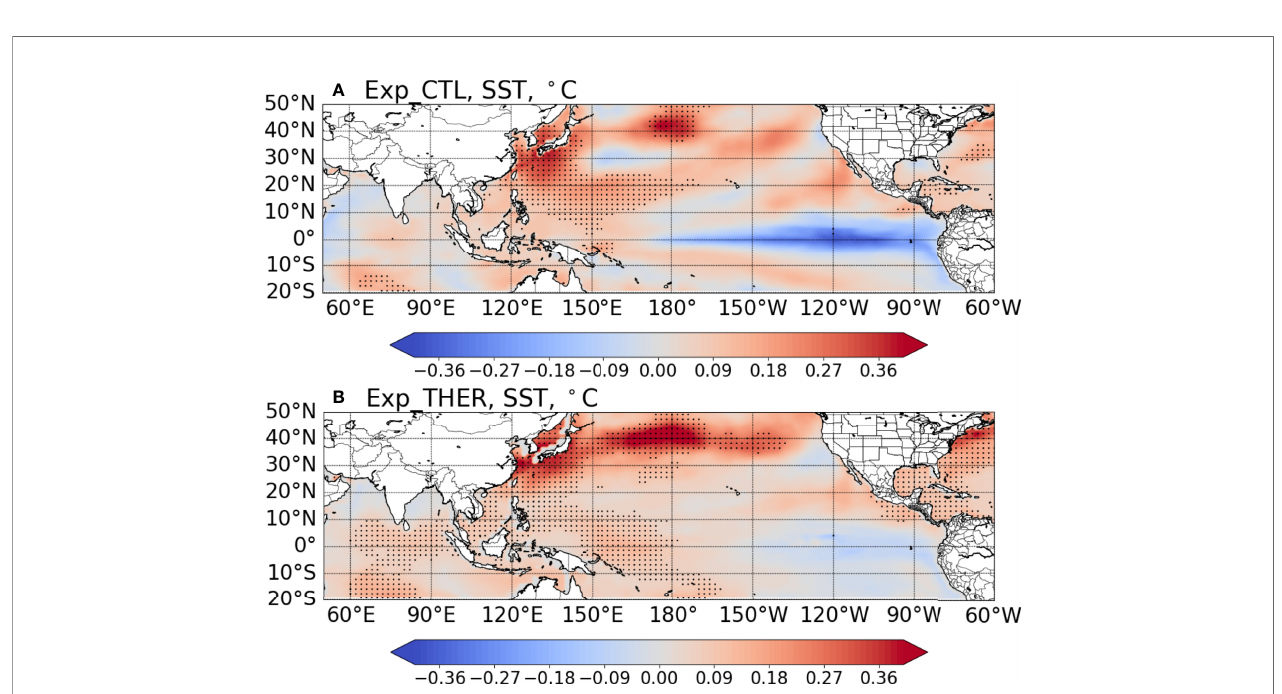
FIGURE 7 | (A) EOF1 spatial pattern of the total frequency of summer MHWs in EAMS, analyzed by Exp_CTL of MOM5 from 1982 to 2020. (B) EOF1 PC time series of EAMS summer MHWs analyzed with Exp_CTL as in (A) . (C) Same as (A) but with the EOF1 spatial pattern analyzed with Exp_THER. (D) EOF1 PC time series of Exp_THER as in (B) . The dotted lines in (B, D) indicate a linear trend. As in Figure 2A , the unit is loaded on the PC time